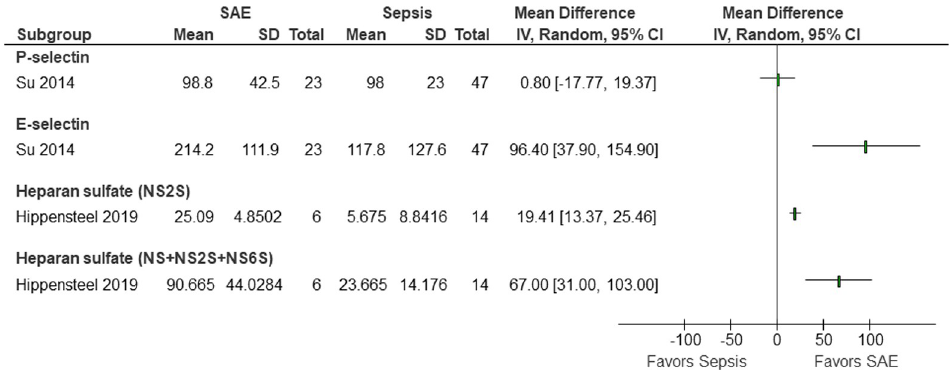
Fig 3. Levels of other biomarkers reported only by single studies. Single studies reported higher mean concentrations of P-selectin, E-selectin, and heparan sulfates in patients with SAE compared to patients with sepsis